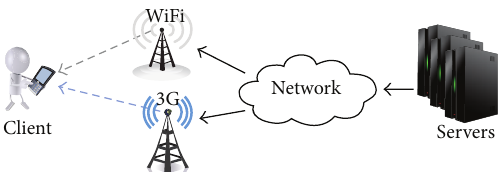
Figure 15: A client device equipped with multiple network inter- faces which has several active network